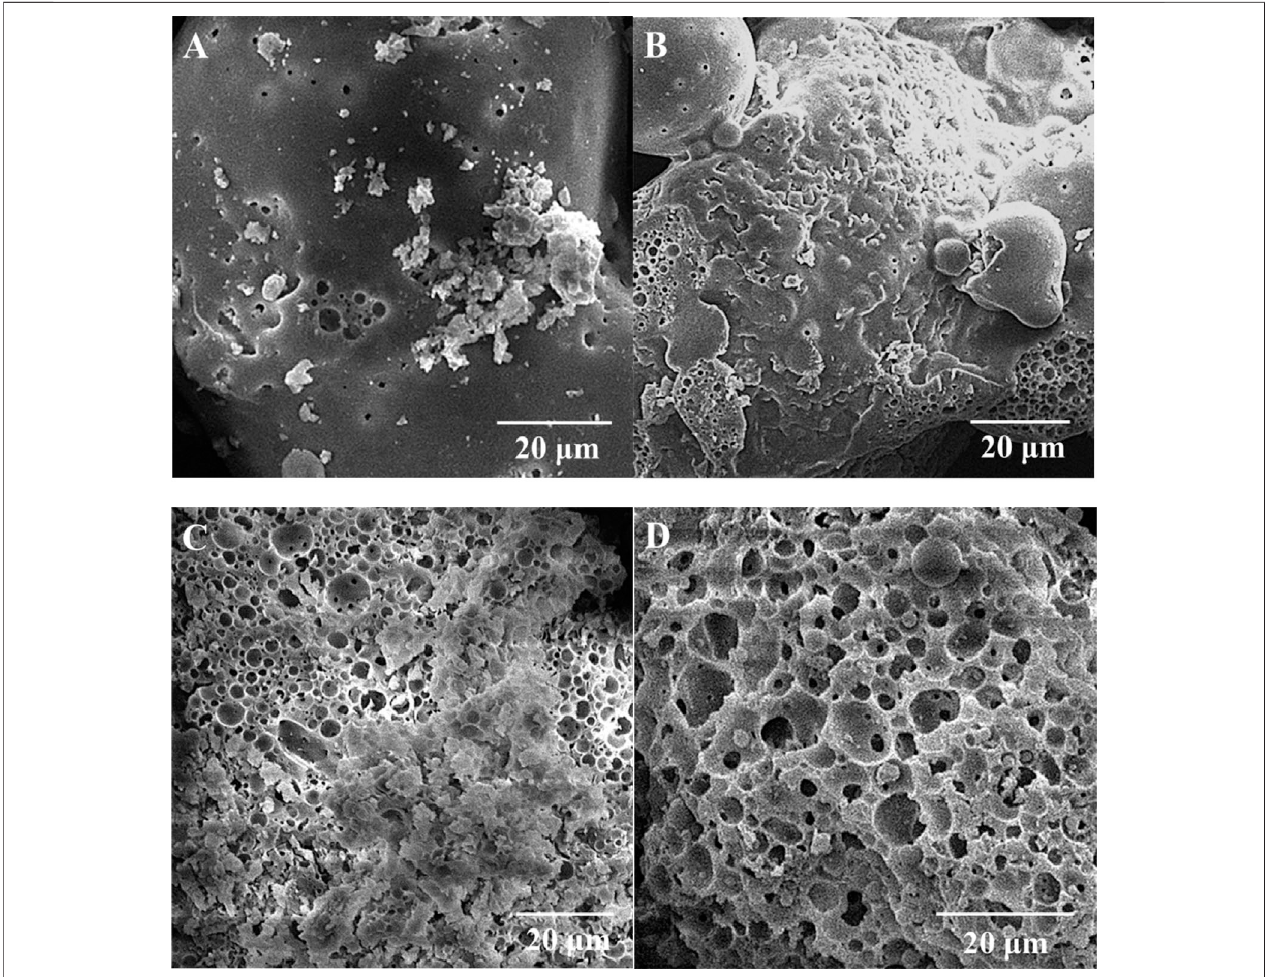
FIGURE 4| Scanning electron microscopy images of (A) autoclaved alkali lignin, (B) I. lacteus treatment, (C) P. chrysosporium treatment, and (D) fungal coculture treatment.